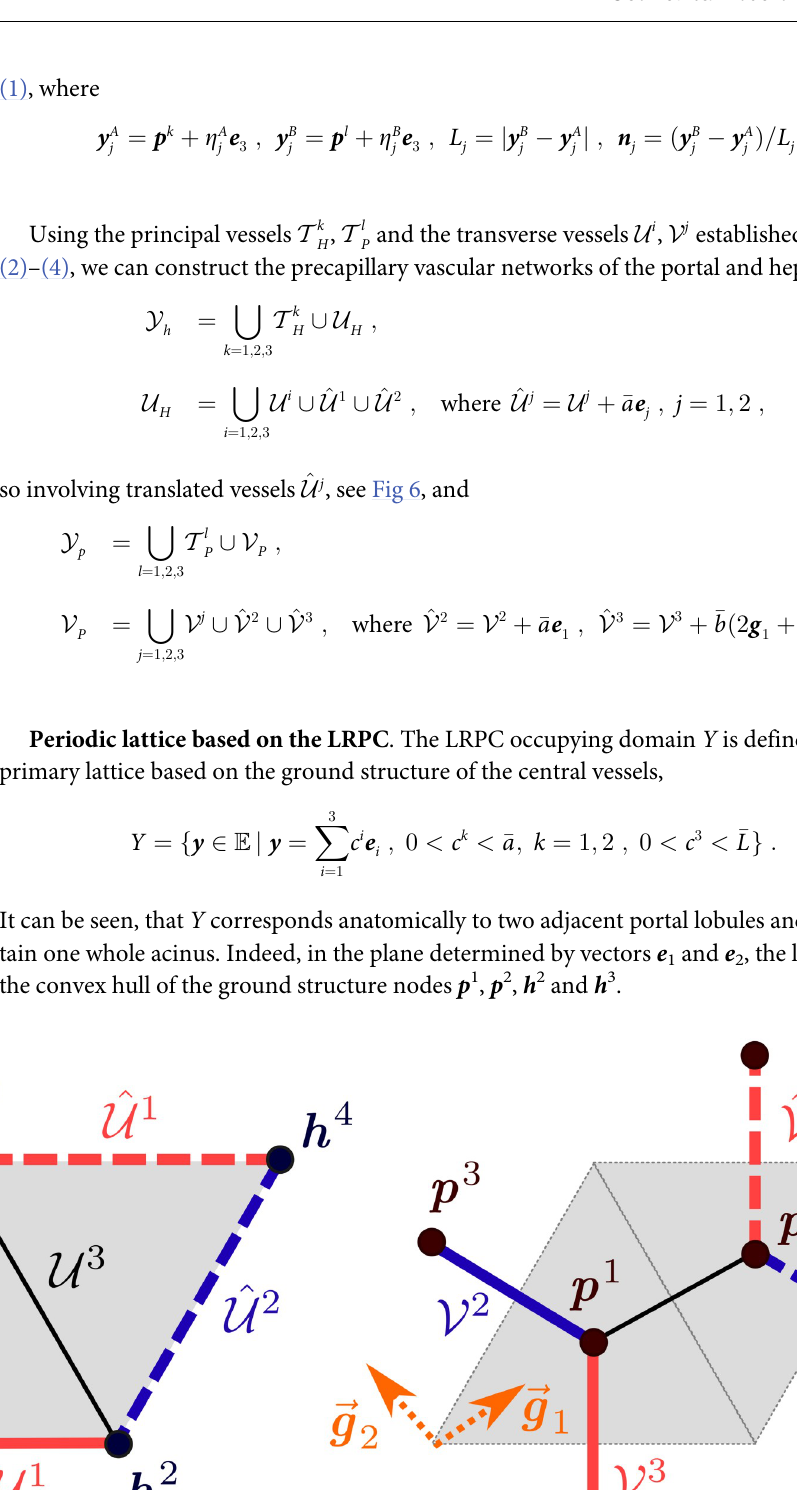
Fig 6. Translations employed to define Y